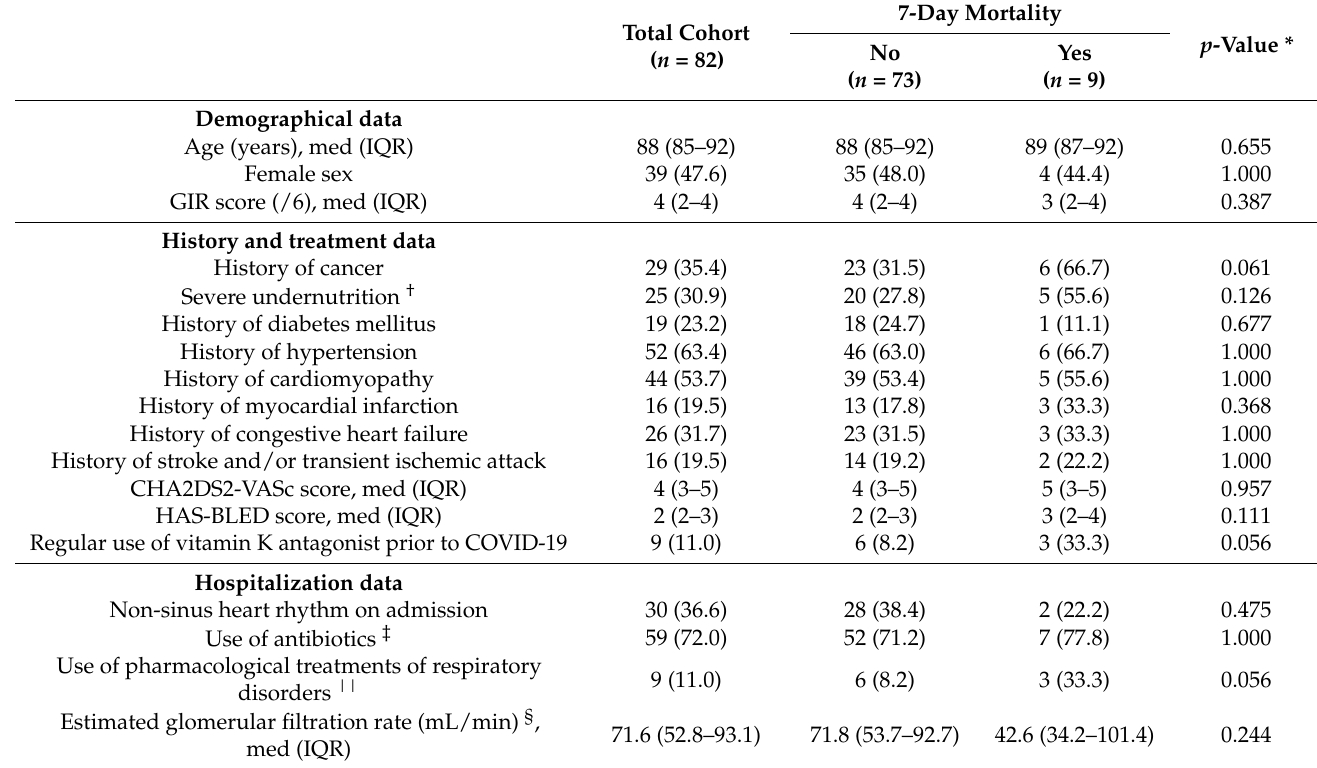
Table 1. Characteristics and comparison of COVID-19 participants ( n = 82) separated into two groups according to 7-day mortality.